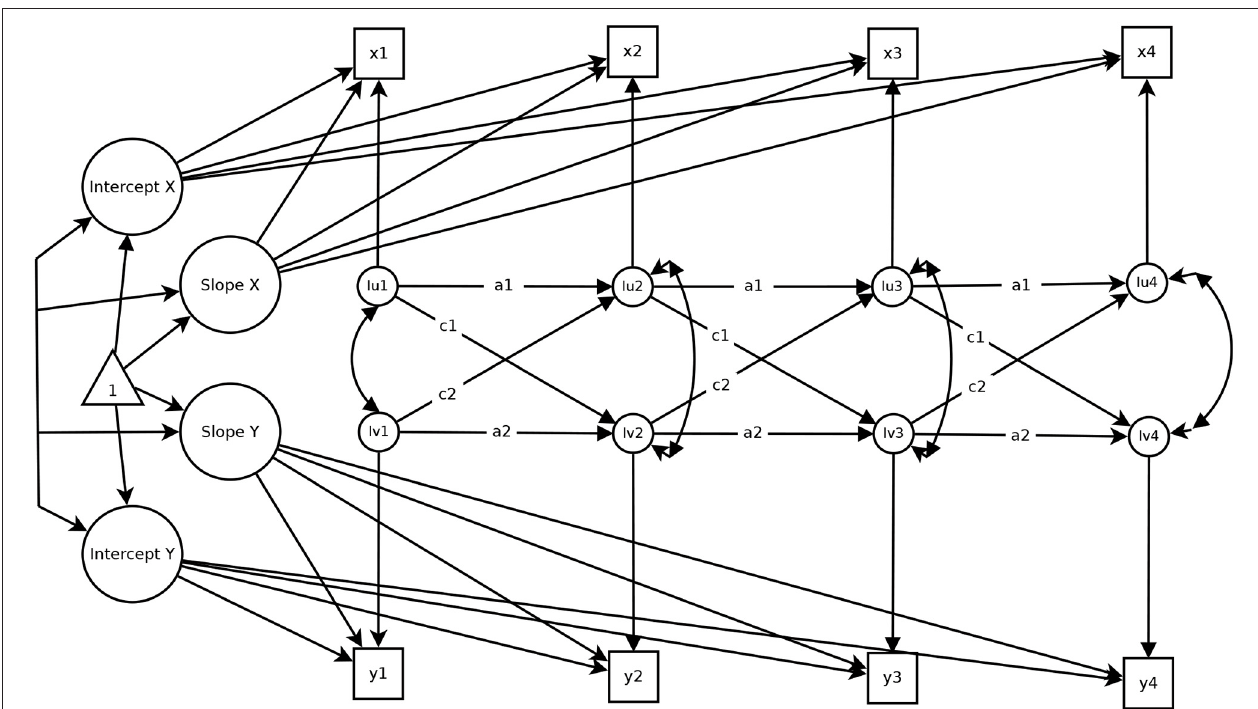
FIGURE 3 | A Latent Curve Model with Structured Residuals over four measurement occasions. Figure is available under a CC-BY 4.0 license at